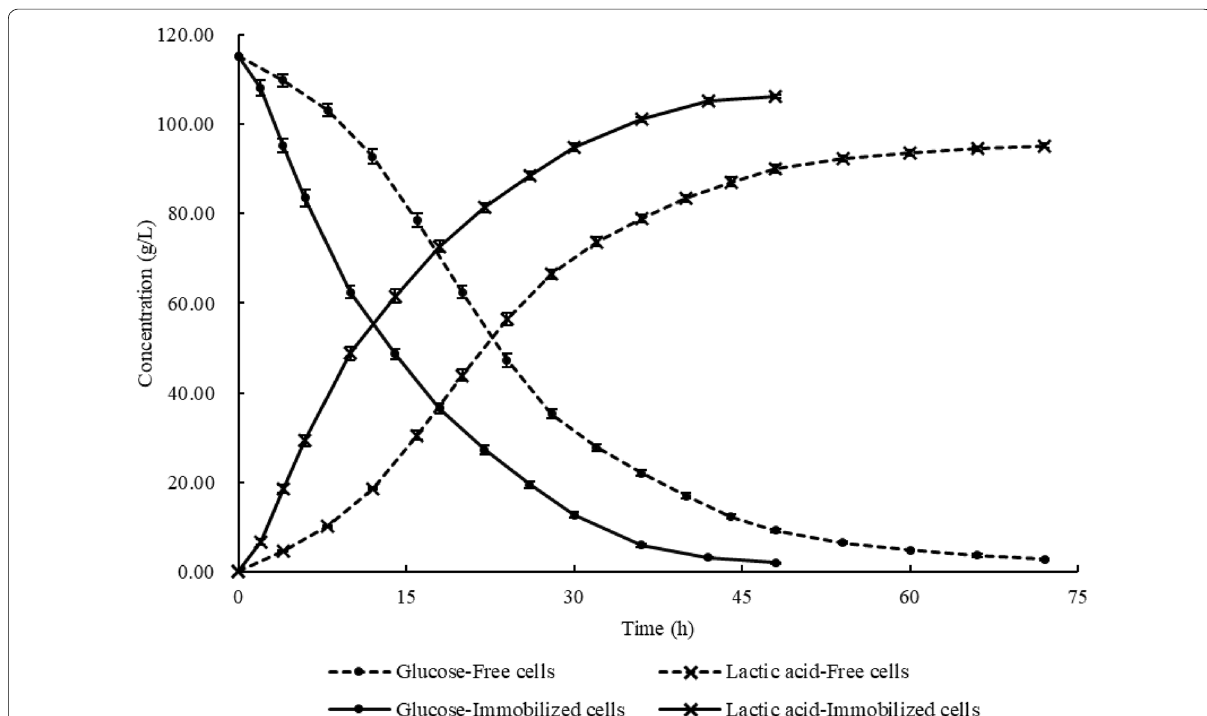
Fig. 3 Time profiles of LA and glucose concentrations during the fermentation process of immobilized L. pentosus ATCC 8041 cells and free L. pentosus ATCC 8041 cells